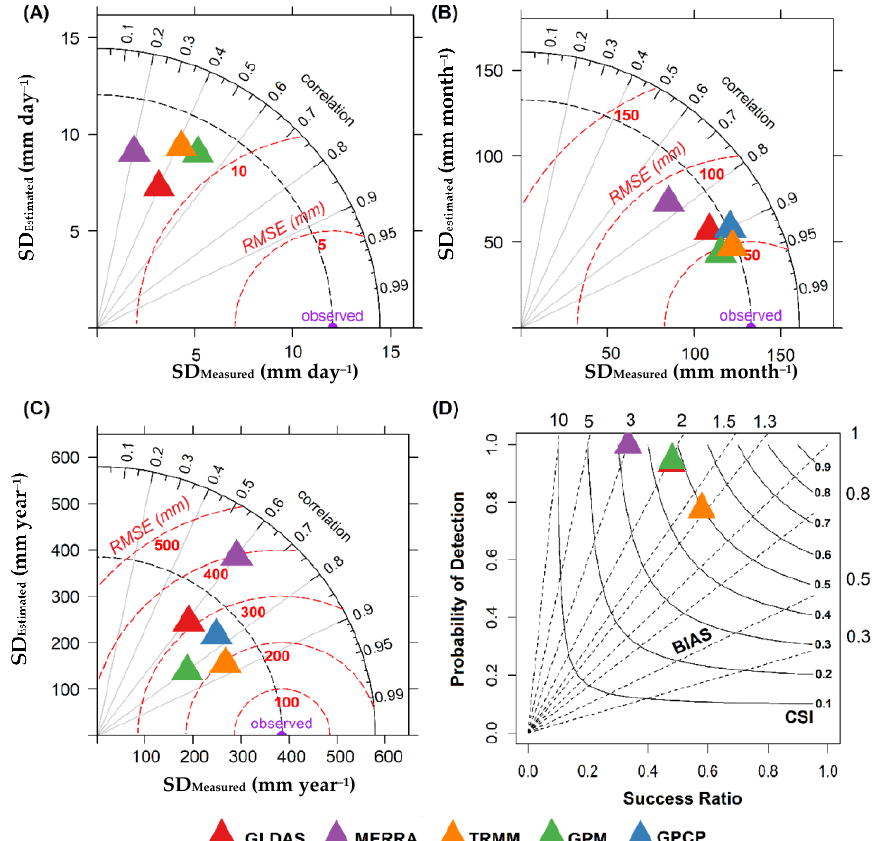
Figure 4. Taylor diagrams showing the comparisons of ( A ) daily (mm day −1 ), ( B ) monthly (mm month −1 ), ( C ) annual (mm year −1 ) measured and estimated precipitation as well as ( D ) the perfor- mance diagram of GLDAS, MERRA, TRMM, GPM, and GPCP products in the state of Mato Grosso, Brazil. In panels A, B, and C, the Pearson correlation coefficient (r) is represented by the azimuth angle (black outlines), the Root Mean Square Error (RMSE) is represented by the red dashed outlines, and the standard deviation (SD) was indicated on the x and y axes, respectively. In panel D, the probability of detection (POD) is represented on the x and y axes; the BIAS was indicated by the dashed black lines; and the critical success index (CSI) is represented by continuous black lines. For ( A ), the daily values for the entire study period were averaged, while for ( B ), the total monthly values for all months during the study period were averaged, and the annual values in ( C ) were the annual values averaged for all years during the study period.